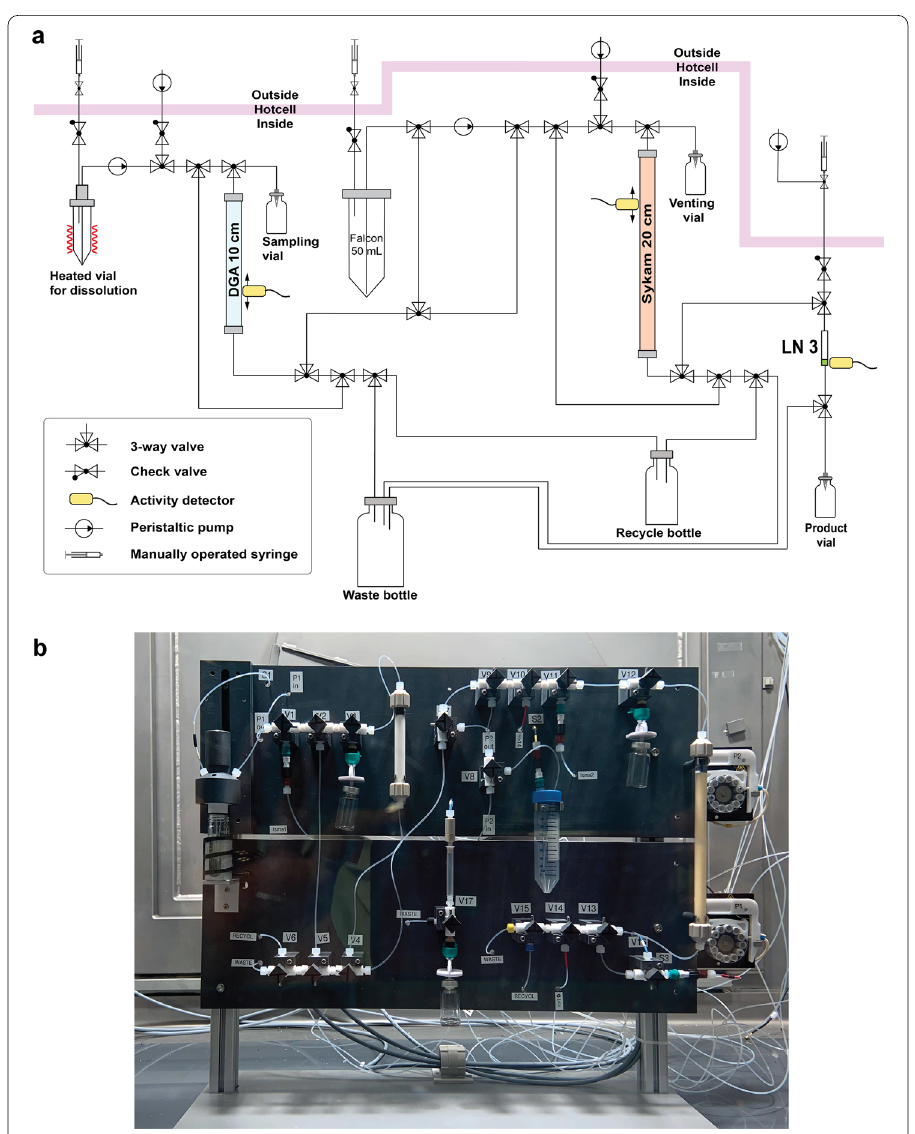
Fig. 5 Schematic diagram of the terbium-155 separation panel ( a ) and image of the actual system ( b ). (Blue, orange and white colors in the diagram represent the columns that contain DGA, Sykam and LN3 resins,